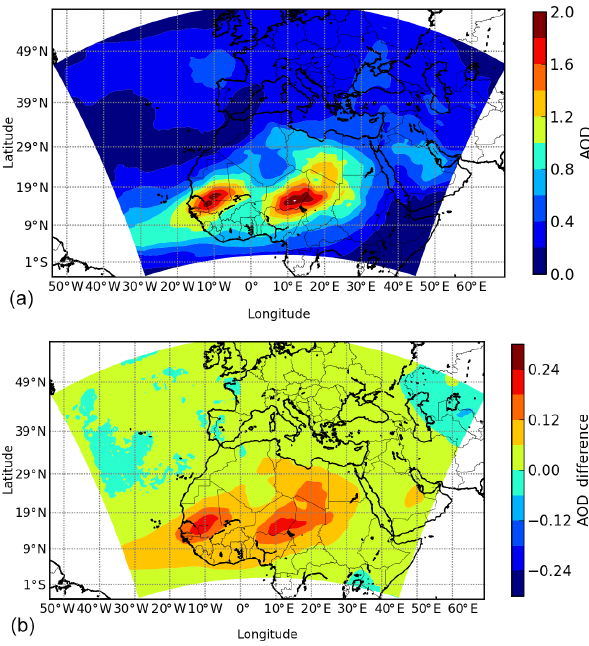
Figure 7. Monthly averaged aerosol optical depth for April 2012 and over the whole modelled domain. (a) AOD absolute values are presented for the simulation DUST. (b) The map of difference rep- resents the calculation of